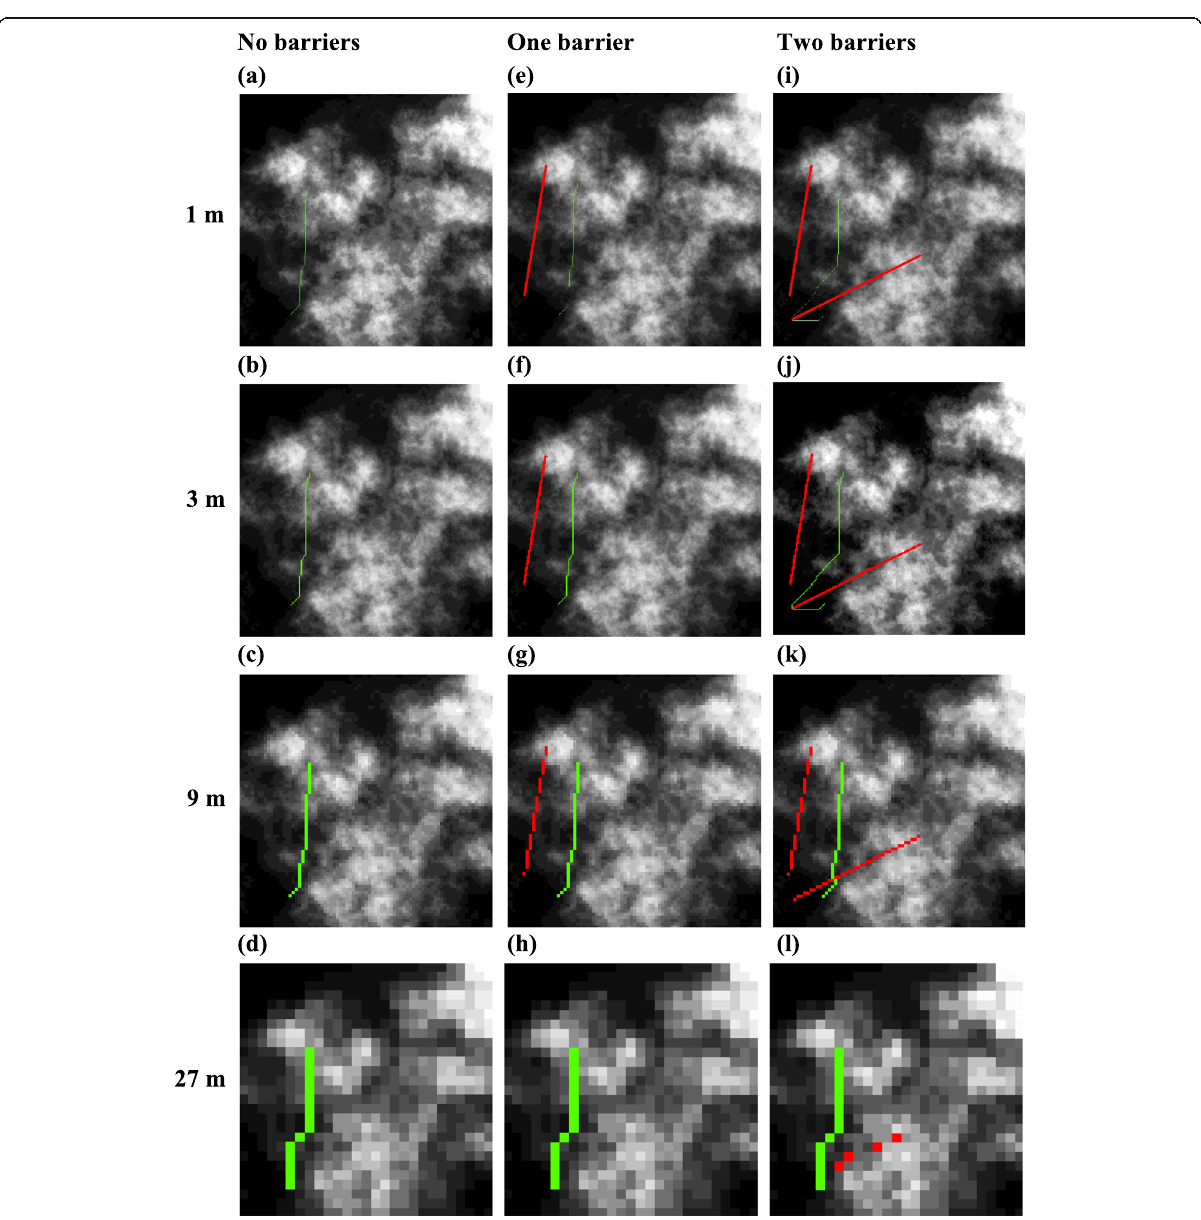
Fig. 4 Least-cost paths (colored in green) on the 12 cost surfaces with different resolutions and different numbers of linear barriers (colored in red) derived from a common neutral landscape model shown in Fig.